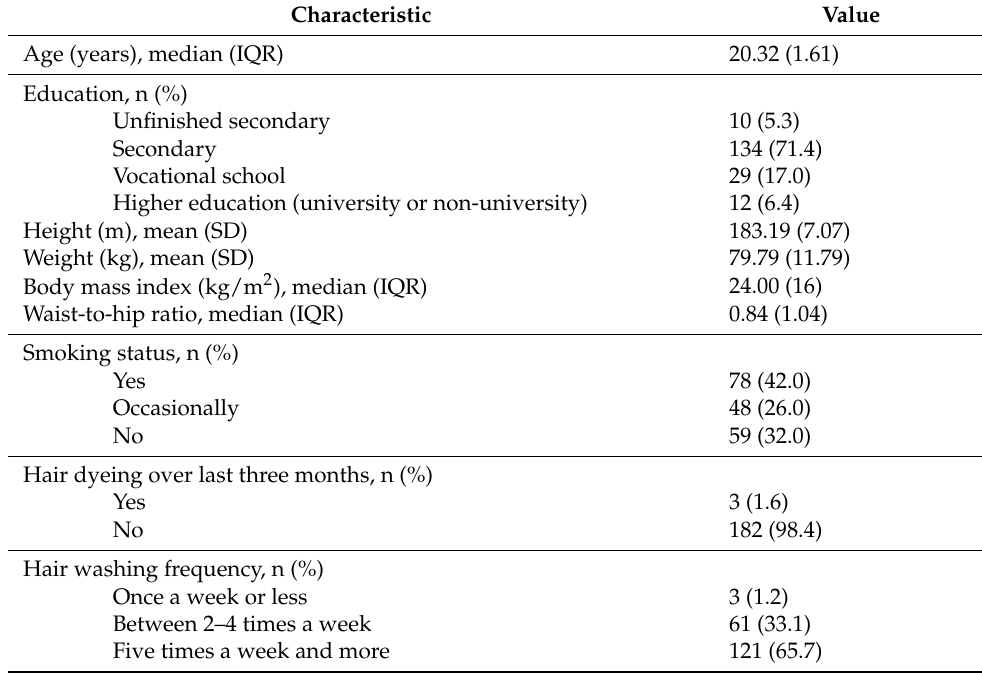
Table 1. Anthropometric values and lifestyle details of the study